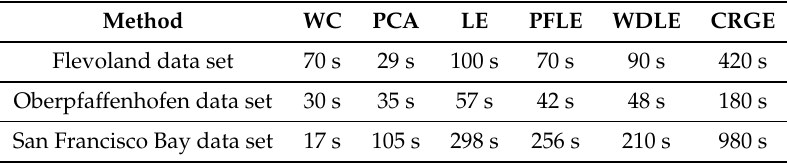
Table 5. Computational time of six methods on three data